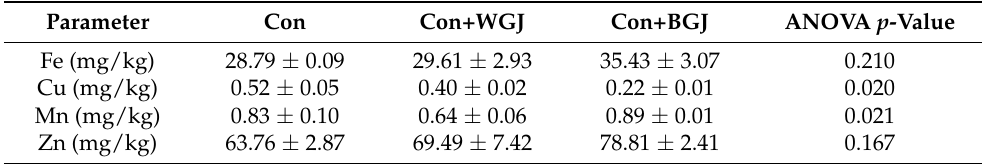
Table 5. Elemental composition in common carp meat fed with plant-based diet and 2% wheat grass juice (WGJ) and barley grass juice